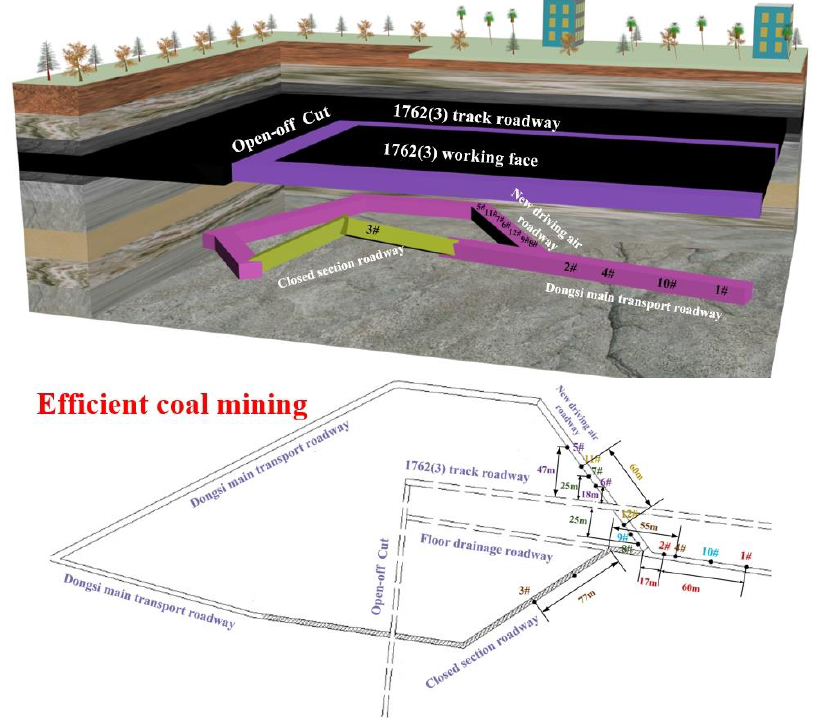
Figure 3. Layout of measuring